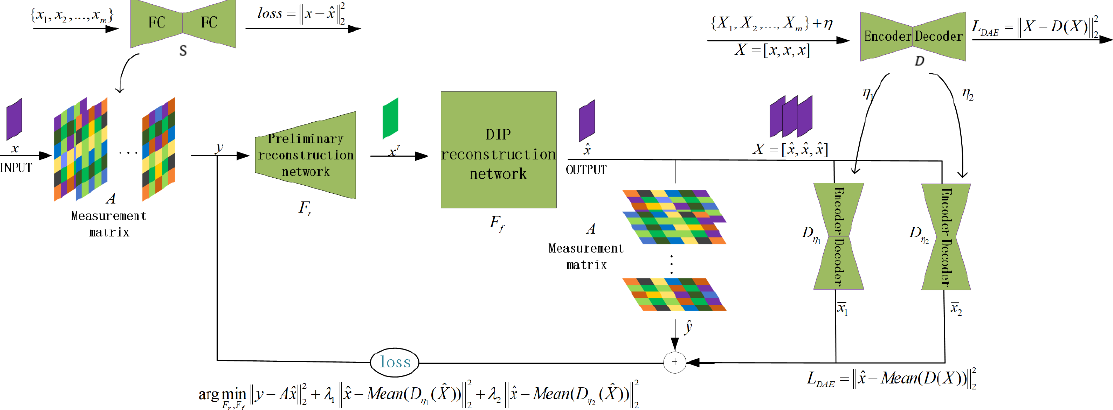
Figure 3. Structure of the proposed DPAP, where Mean ( · ) means to average the three-channel image.